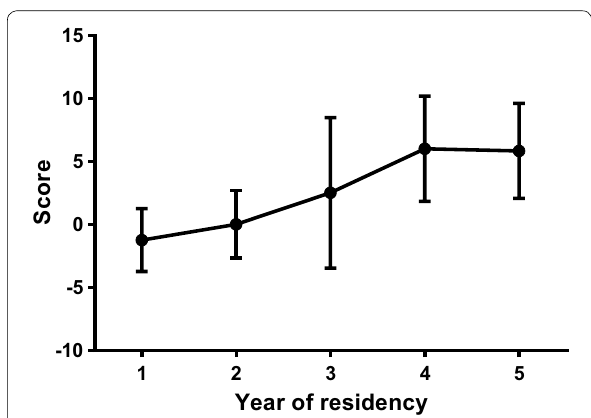
Fig. 4 Mean performance rating score in residents subdivided by year. Error bars represent standard deviations. The development of residents’ skills in pleural effusion ultrasound and chest drain position- ing appears to progress steadily with increasing years of residency, reaching a plateau in the last 2 years. p =